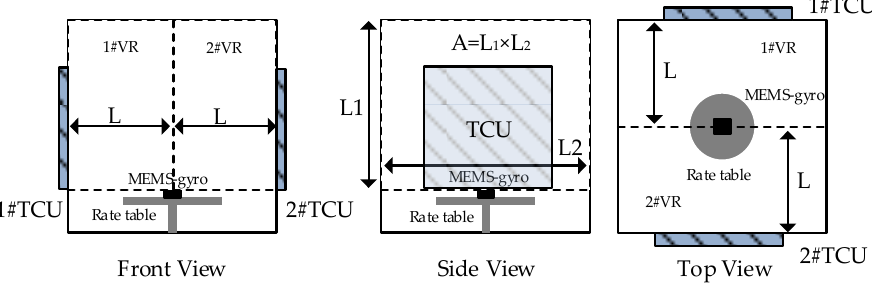
Figure 7. Schematic diagram of MEMS-gyros installed on the rate table inside the thermal chamber.